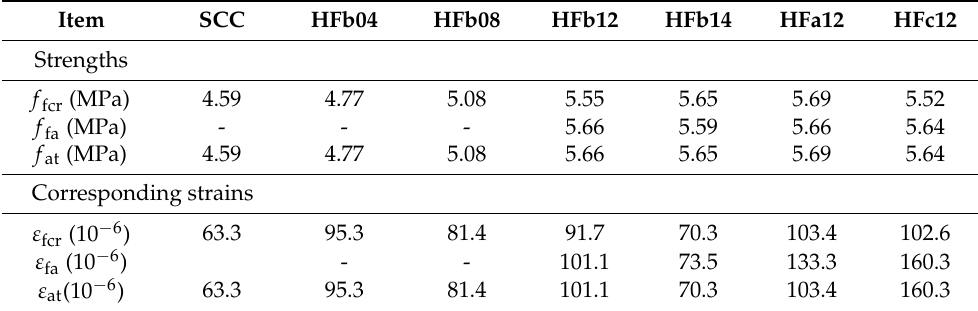
Table 2. Test results of axial tensile strength and